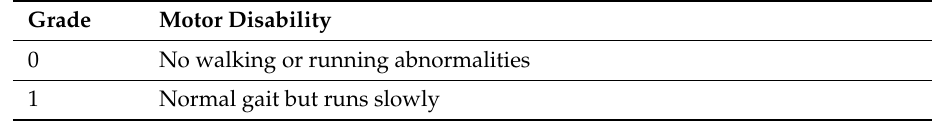
Table 3. Osame motor disability score